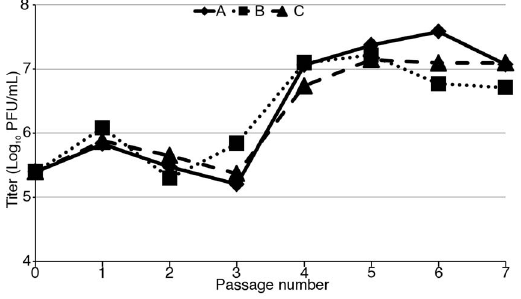
Figure 2. Experimental evolution of VV D E D K + RhTRS1 increases replication fitness in PRO1190 cells. PRO1190 cells were initially infected with VV D E D K + RhTRS1 (MOI=0.1). Virus was harvested at 48 hpi, titered on BSC40 cells, and used to infect fresh PRO1190 cells and the process was repeated. Three independent infections resulted in an , 10-fold to 100-fold gain of replication fitness in PRO1190 that was evident by passage four.